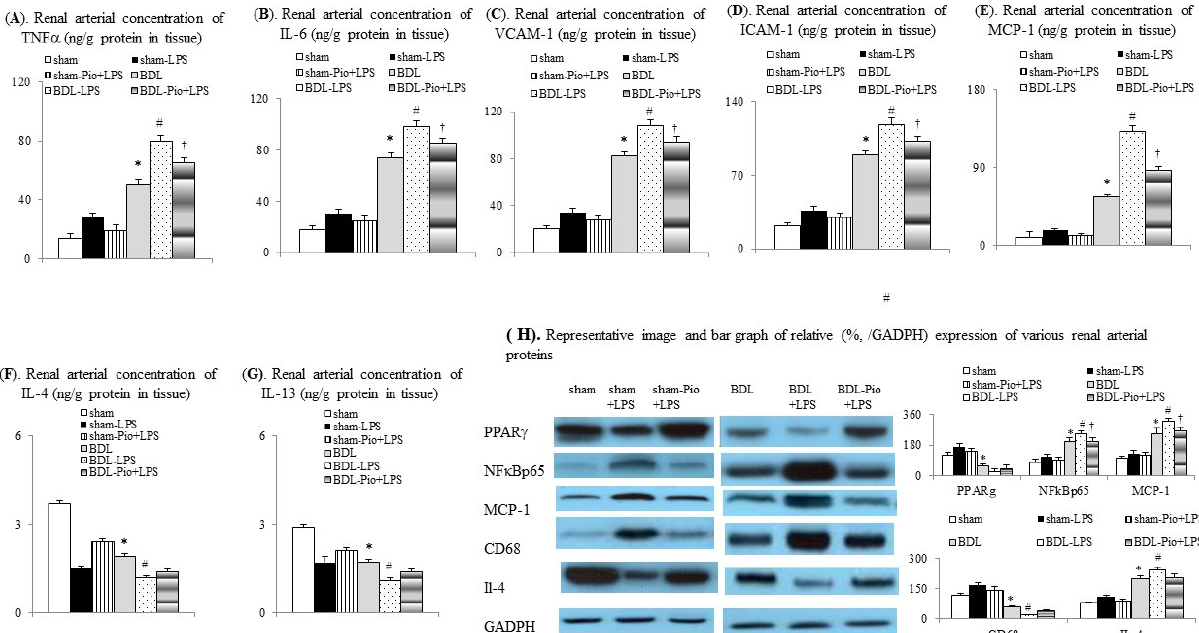
Figure 5. Chronic pioglitazone treatment inhibited the lipopolysaccharide (LPS)-induced vascular inflammation in rat cirrhotic renal arteries. Renal arterial concentrations of ( A ) TNF α , tumor necrosis factor α (TNF α ), ( B ) interleukin-6 (IL-6), ( C ) vascular cell adhesion molecule-1(VCAM-1), ( D ) intracellular adhesion molecule-1 (ICAM-1), ( E ) monocyte chemoattractant protein-1 (MCP-1), ( F ) interleukin-4 (IL-4), and ( G ) interleukin-13 (IL-13). ( H ) Expression of various proteins in renal arteries. * p < 0.05 vs. sham group; # p < 0.05 vs. BDL group; † p < 0.05 vs. BDL ‐ LPS.